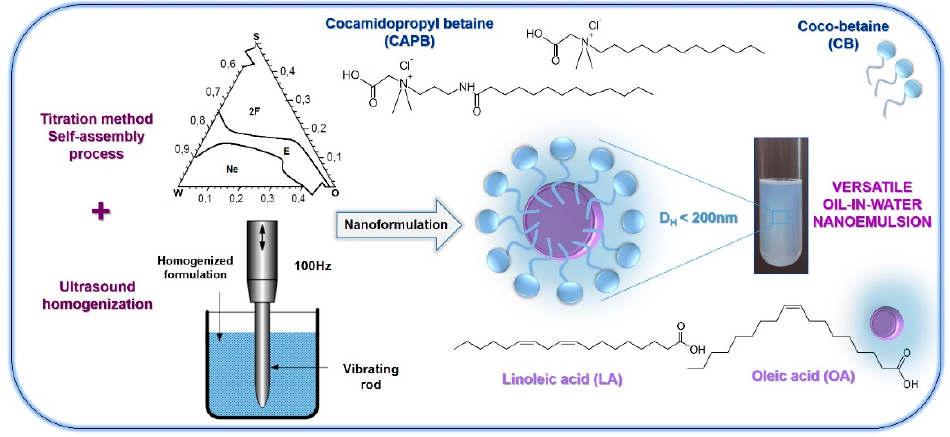
Figure 1. The general approach to the instigated studies.